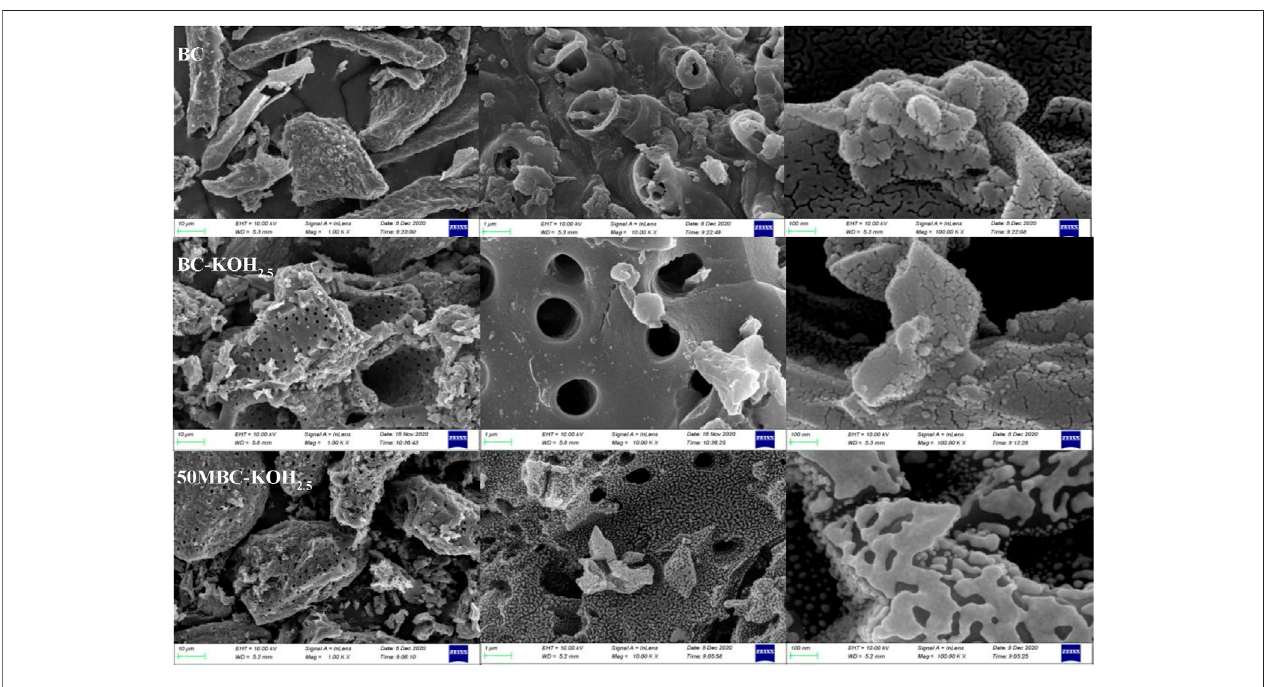
FIGURE 1 | SEM images of BC, BC-KOH 2.5 and 50MBC-KOH 2.5 .